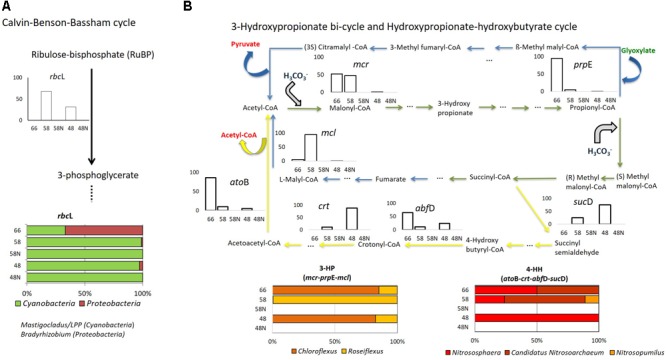
Autotrophy in Porcelana mat. (A) Calvin–Benson–Bassham cycle (rbcL gene); (B) 3-hydroxypropionate bi-cycle (blue arrows: mcl, mcr, and prpE genes), and hydroxypropionate-hydroxybutyrate cycle (yellow arrows: atoB, crt, abfD, sucD genes). Green arrows show the steps shared by the two pathways in Bacteria and Archaea. Bar graphs show the percent of the total transcripts of each gene found in each sample, during the day (white bars) and night (black bars) at each temperature. The lower horizontal bars show the percent contribution of the main taxa to transcription for each process at each temperature.